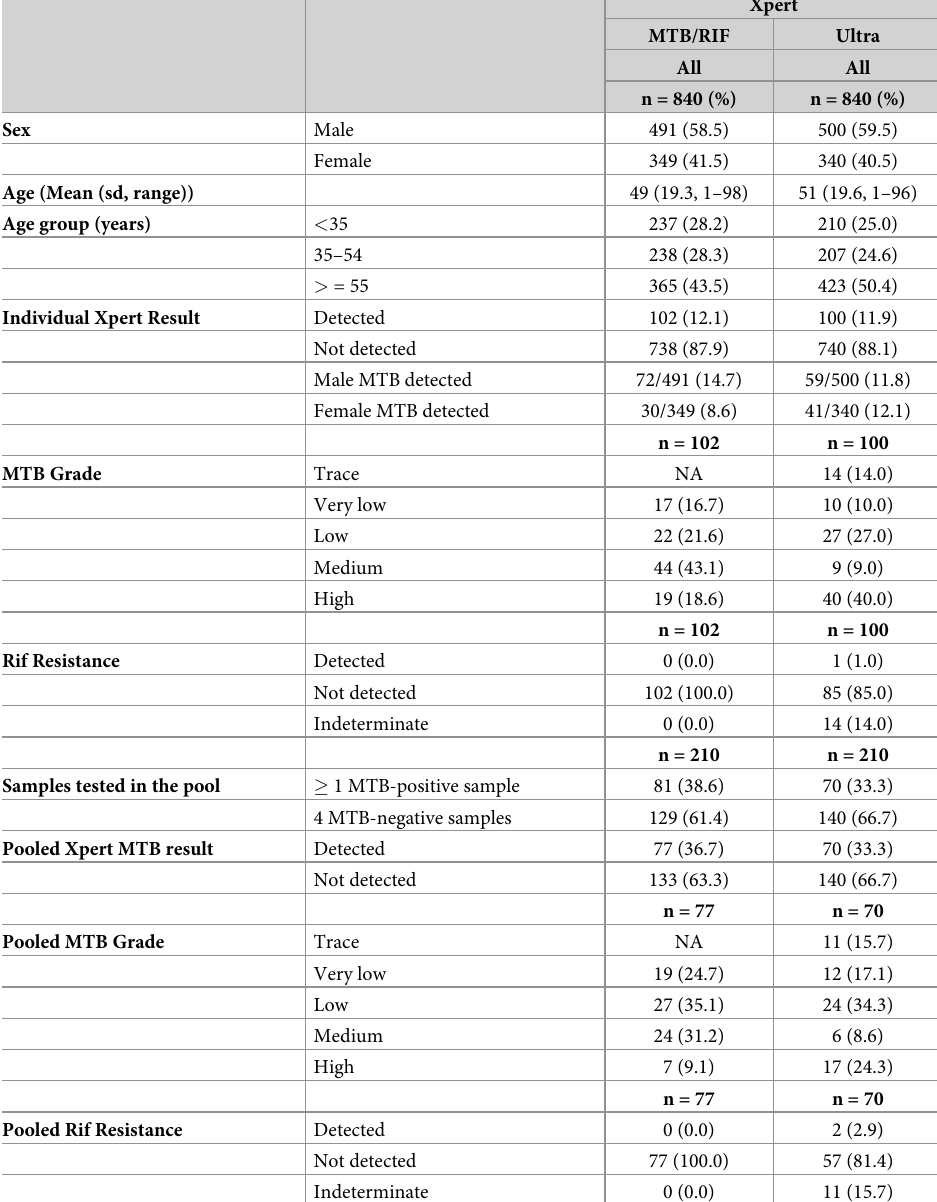
Table 1. Baseline characteristics of participants with single and pooled Xpert